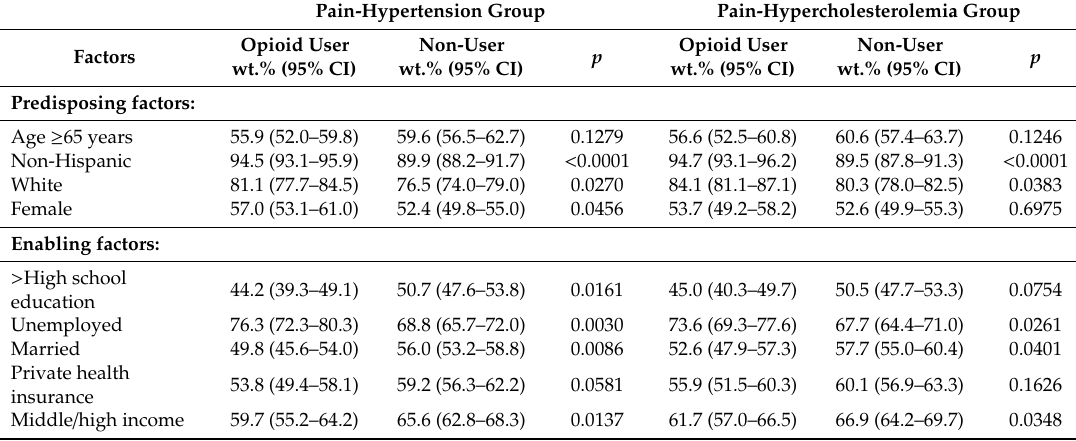
Table 1. Select characteristics of United States older adults (age ≥ 50 years) with self-reported pain in the past four weeks and a diagnosis of hypertension or